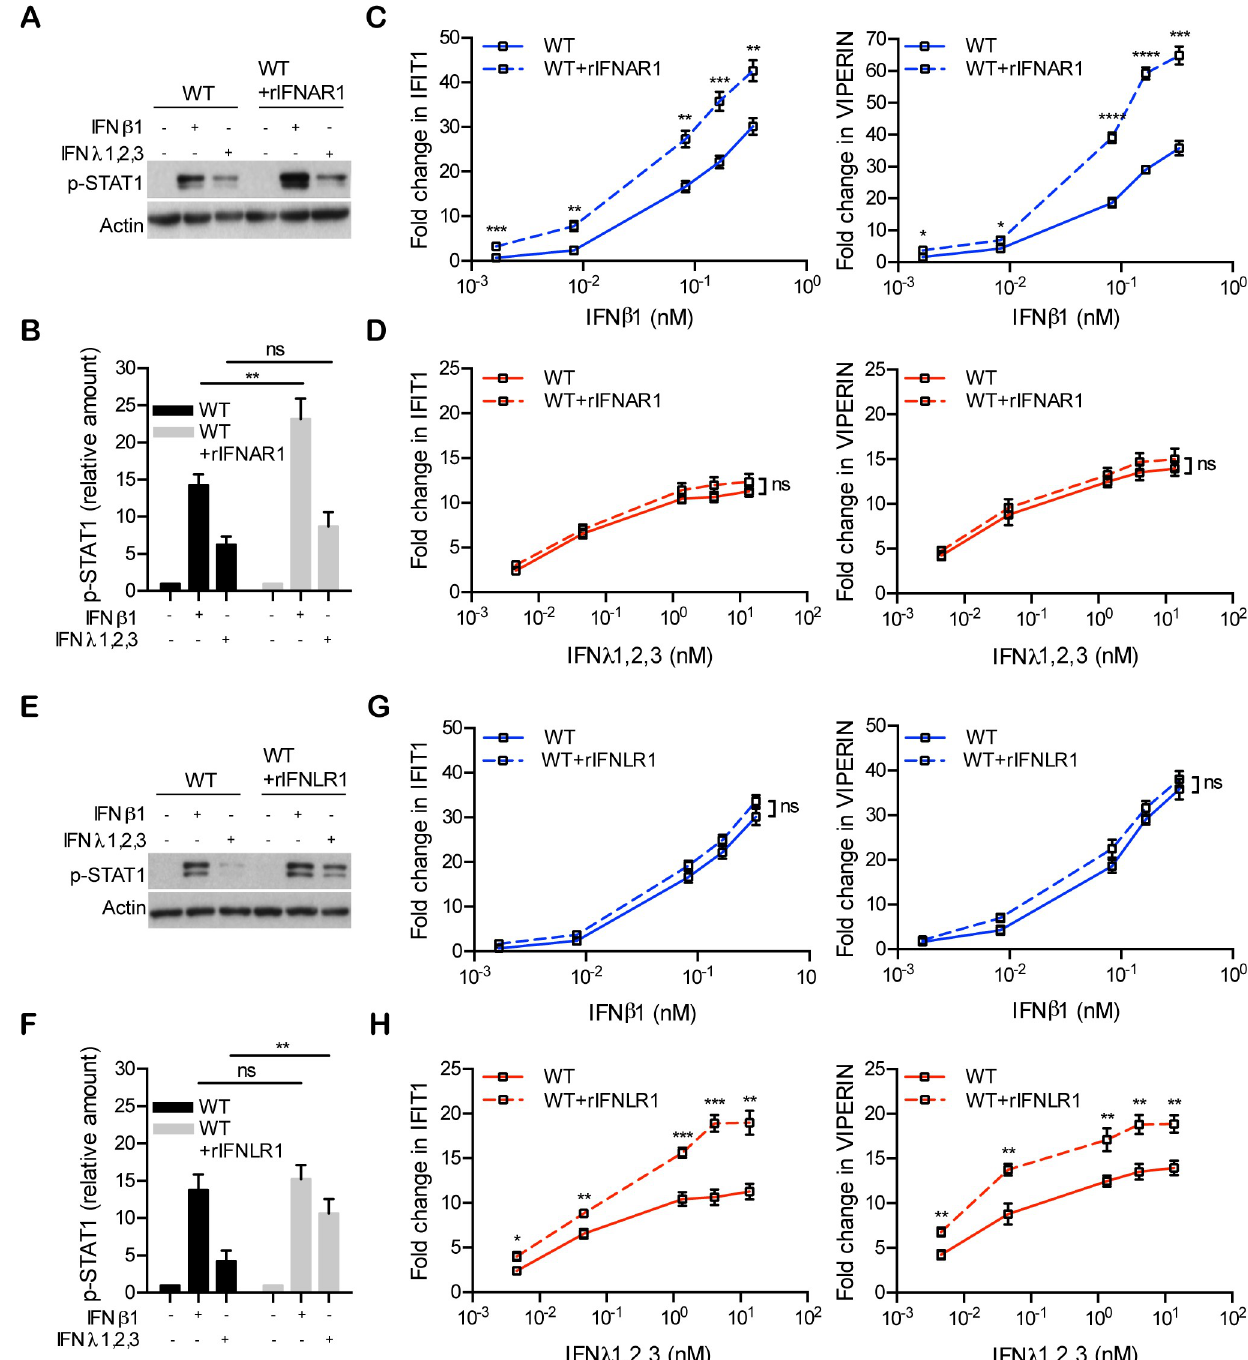
Fig 6. Overexpression of type I and type III IFN receptor increases the transcriptional activity of both cytokines. (A-F) Wild-type T84 cells were transduced with rIFNAR1 or rIFNLR1 to create stable lines overexpressing either IFN receptors. (A-B) T84 wild-type cells (WT) and T84 cells overexpressing rIFNAR1 (WT+rIFNAR1) were treated with type I IFN ( β ) (2,000 RU/mL equivalent 0.33 nM) or type III IFN ( λ 1 − 3) (300 ng/mL equivalent 13.7 nM) for 1h and IFN signaling was measured by immunoblotting for pSTAT1 Y701. Actin was used as a loading control. A representative immunoblot out of three independent experiments is shown. (C-D) T84 wild type cells (WT) and T84 cells overexpressing rIFNAR1 (WT+rIFNAR1) were treated with increasing concentrations of type I IFN ( β ) for 12 hours or type III IFN ( λ 1 − 3) for 24 hours and the transcript levels of the ISGs IFIT1 and Viperin were analyzed by qRT-PCR. Data are normalized to HPRT1 and are expressed relative to untreated cells at each time point. (E-H) Same as (A-D), except T84 cells overexpressing rIFNLR1 (WT+IFNLR1) were used. The mean value obtained from three independent experiments is shown. Error bars indicate the SD. � < P.05, �� P < 0.01, ��� P < 0.001, ���� P < 0.0001, ns, not significant (unpaired t-test).